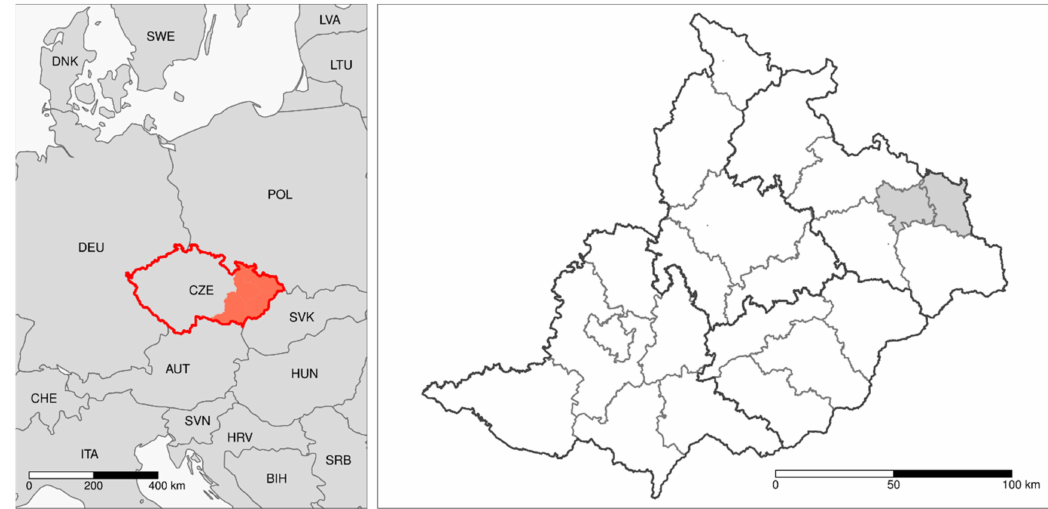
Figure 1. Left: location of the Czech Republic (CZE) in Central Europe and the studied area is colored in red. Right: individual districts (n = 22) within the studied area. The Karvin á and Ostrava districts are shaded grey.